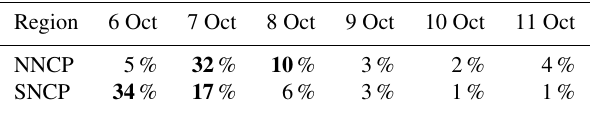
Table 5. Average contribution proportion of crop field burning to PM 2 . 5